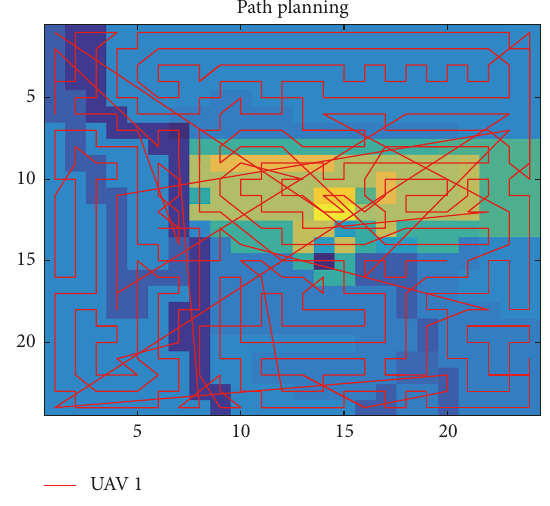
Figure 10: La Palma ANFIS path planning.